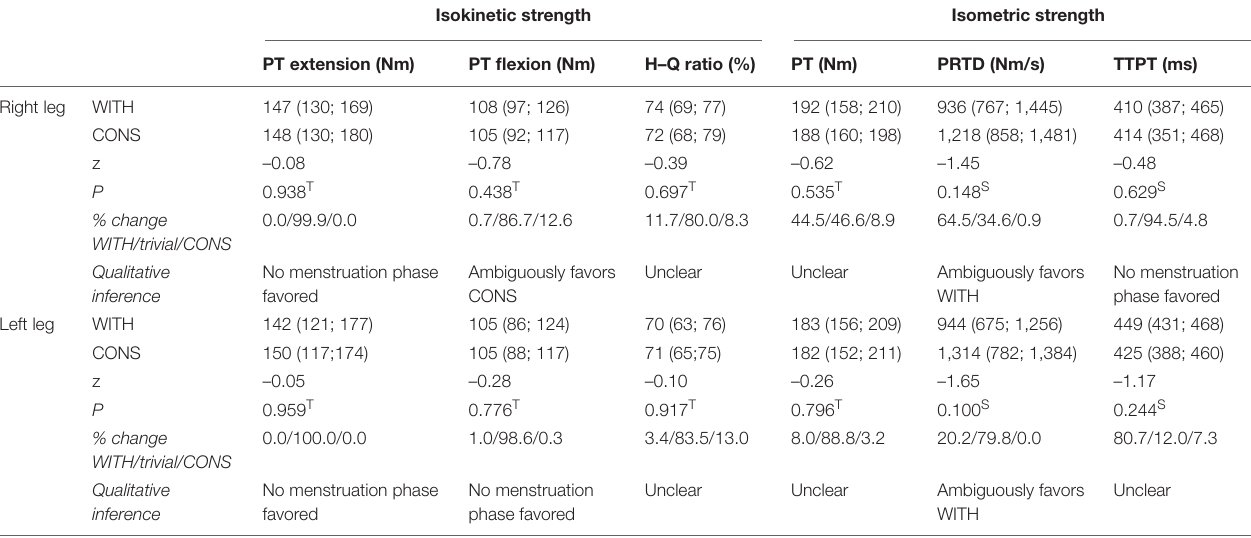
TABLE 1 | Descriptive data of isometric and isokinetic knee-extensor and flexor parameters comparing OCP withdrawal and consumption ( n = 16).